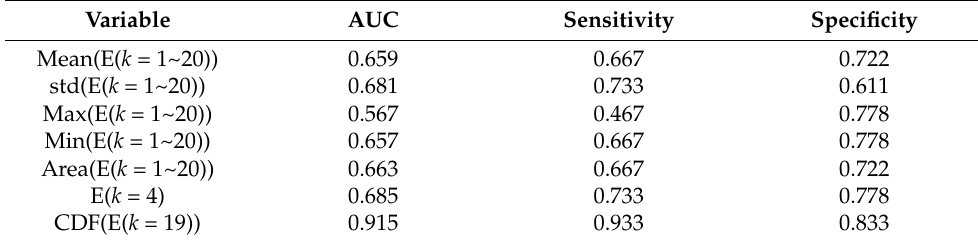
Table 2. The AUC of variables related to the entropy value of iPR.